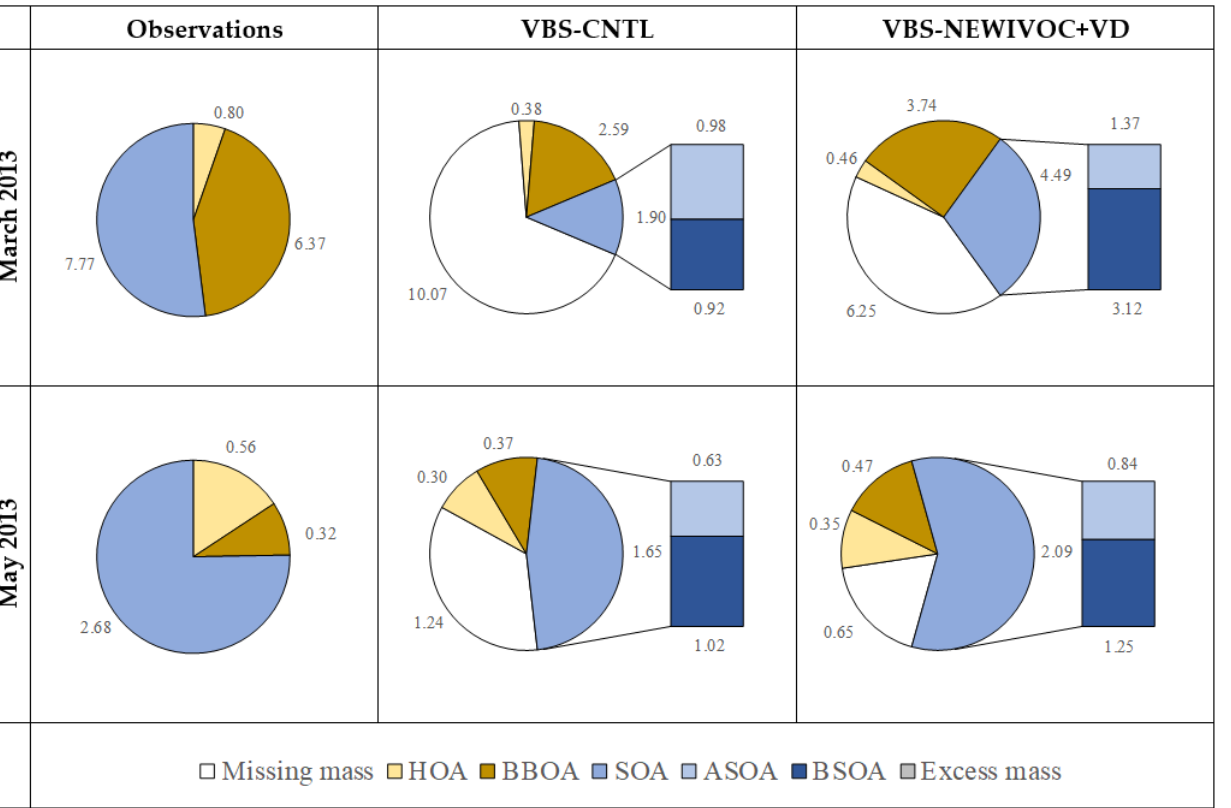
Figure 16. OA average composition (µg m −3 ) for March 2013 and May 2013 at the Ispra site: observations (PMF results), VBS-CNTL simulation, and VBS-NEWIVOC+VD simulation. ASOA = anthropogenic SOA; BSOA = biogenic SOA, SOA from anthropogenic biomass combustion and from biogenic emissions.